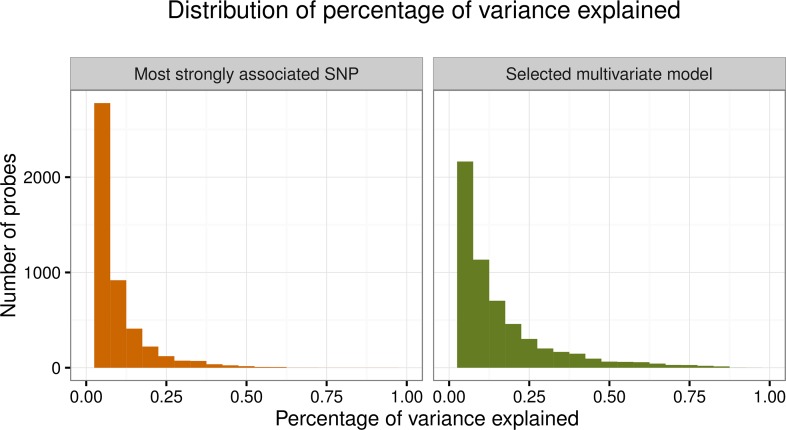
Distribution of percentage of variance explained.Percentage of variance explained (model r2) by the most strongly associated eSNP and by the best set of eSNPs selected using multivariate model selection for the 7,280 heritable probes with local or distal eAssociations.